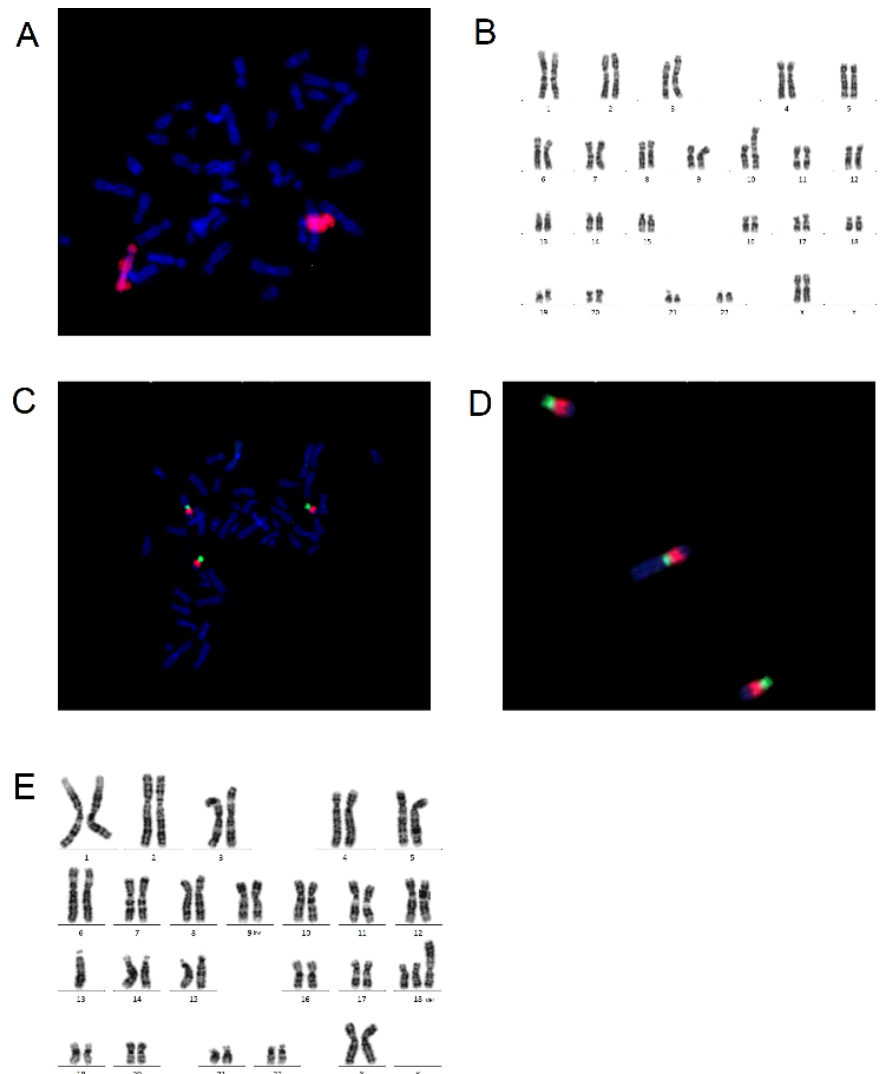
Figure 3. Metaspread with use of whole chromosome painting-WCP and M-band and karyotypes: ( A ) metaspread with WCP10 with orange dye shows gain of genetic information from chromosome 10; ( B ) karyotype on patients with duplication of long arm of chromosome 10: 46, XX, dup (10) (q11q26); ( C ) multicolor chromosome banding probe on chromosome 18; ( D ) zoomed picture of 3 chromosomes 18 with M-band probes; and ( E ) karyotype of newborn with trisomy of 18 presented in rare form: 46, XX, der (13;18) (q10; p10) +18 (source: Author with permission of Medirex laboratory).